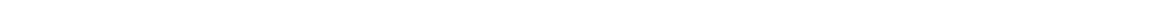
Fig. 6 F-actin dynamics and vinculin recruitment at cell junctions. a Time-lapse images of Lifeact-EGFP expressed in HT29 cells during nocodazole treatment in control (upper panels) or α E-catenin depleted cells (lower panels). Protrusions emerged from the cell periphery in control cells, whereas only bubbling occurred in the absence of α E-catenin. Light blue arrows/dot indicate the original position of Lifeact-EGFP positive edges, and this edge is shifted inward as indicated by light green arrows/dots. Asterisks label neighboring cells. Boxed area is enlarged below. Images are identical to Supplementary Movies 4, 5. b Laser ablation of Lifeact-EGFP labeled protrusions in HT29 cells treated with nocodazole. Yellow arrowheads indicate the site for laser application. Length of retraction toward the cortical and junctional sides was measured, and the ratio of the two values is shown. n = 45 protrusions pooled from three independent experiments. Images are identical to Supplementary Movie 6. c Effects of vinculin knockdown on the distribution of α E-catenin. The ratio of linear to fragmentary junctions was calculated. n = 4217 junctions in 91 colonies for CTRL si; and 2026 junctions in 94 colonies and 3239 junctions in 106 colonies for vinculin si #1 and #2, respectively, pooled from two independent experiments. d Effects of vinculin knockdown on the distribution of F- actin and E-cadherin. Images were obtained with Airyscan. Boxed area is enlarged at the right. Scale bars, 10 μ m a , c , d , 5 μ m ( d right) and 1 μ m ( a -enlarged images, and b ). See also Supplementary Fig.